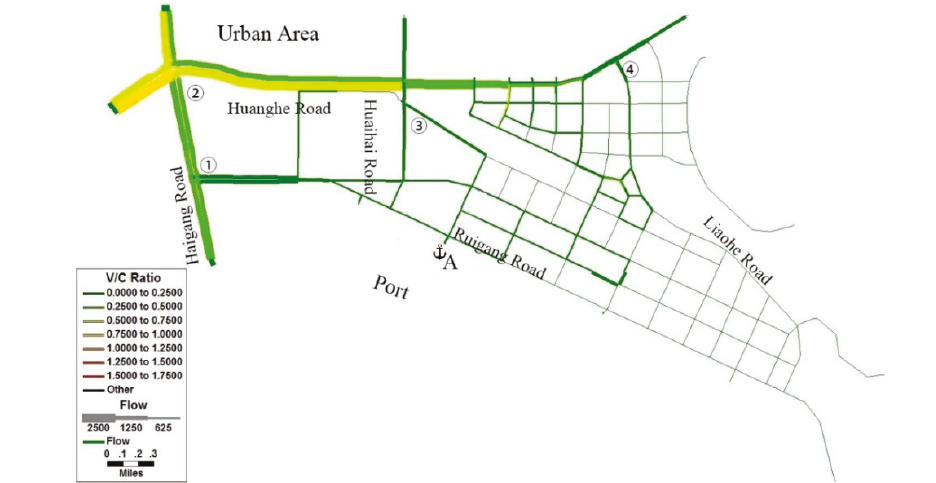
Figure 17: The traffic volume of PCDN in 2015 without